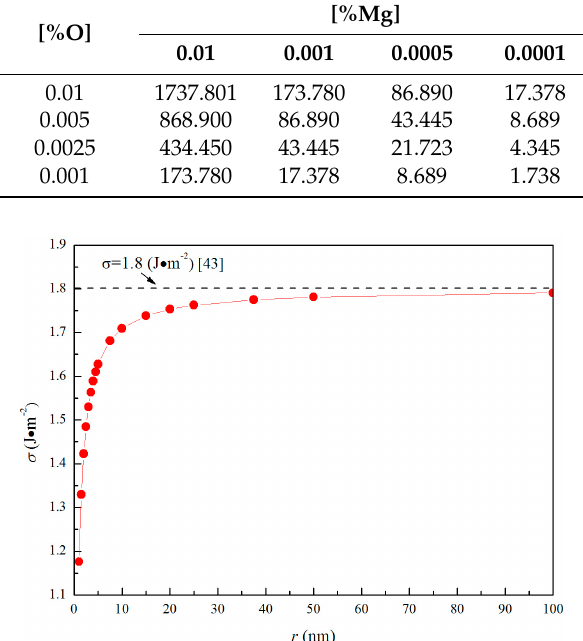
Figure 4. Interfacial free energies between Fe-O-Mg melt and magnesia.